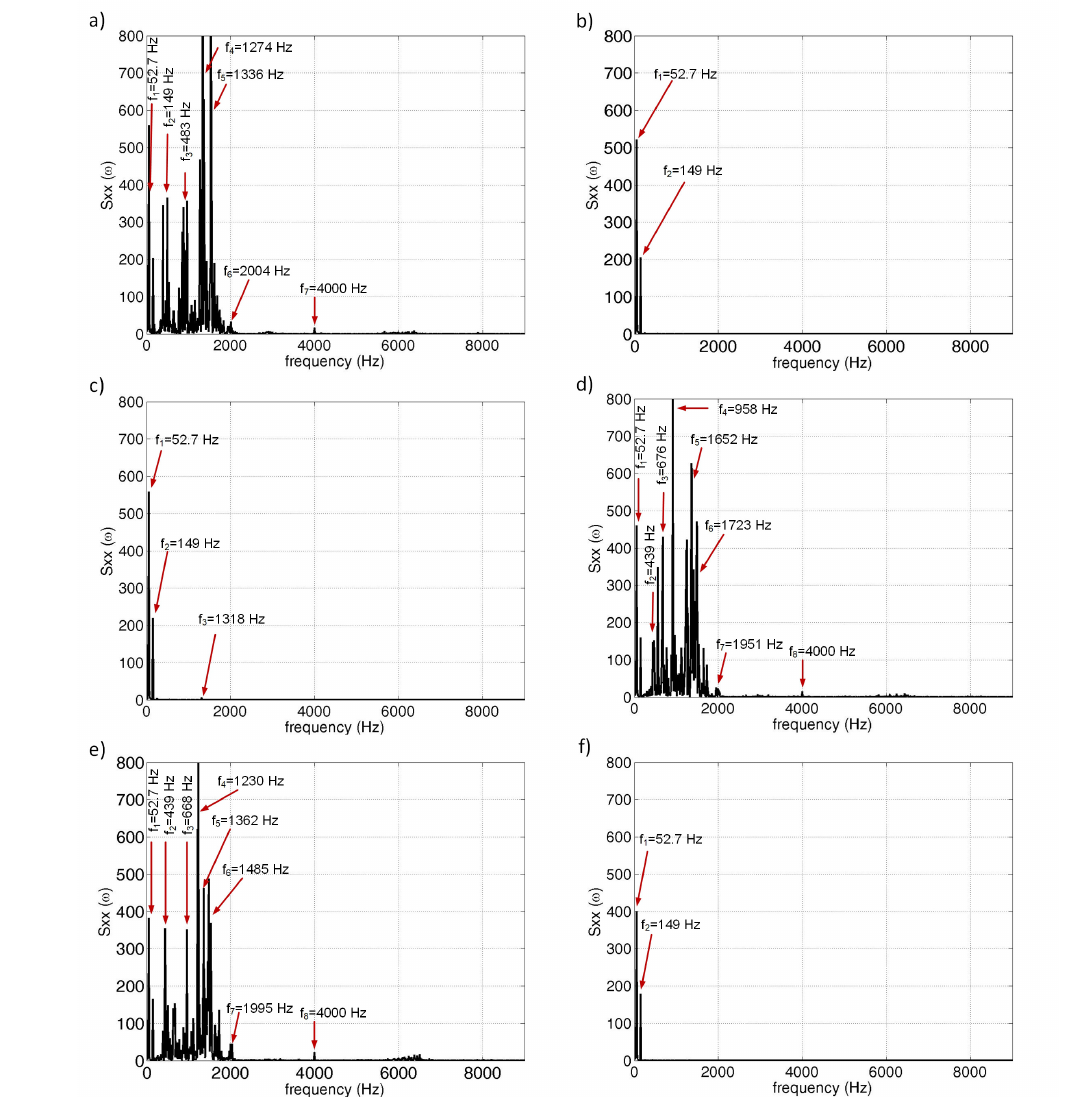
Figure 11. Power spectra by FFT algorithm (( a ) frequency power spectrum of the vibration signal of the motor, ( b ) the vibration signal of the pump, ( c ) the vibration signal of the hydro-generator, ( d ) frequency power spectrum of vibration signal of motor and pump, ( e ) frequency power spectrum of vibration signal of motor and hydro-generator, ( f ) frequency power spectrum of the pump and hydro-generator vibration